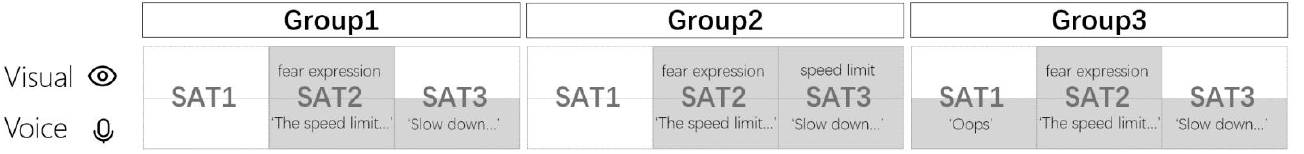
Figure 3. Speeding task experimental group setup. The gray choices represent information that appeared at a certain level in the experimental group, and the white choices represents that there is no information in that